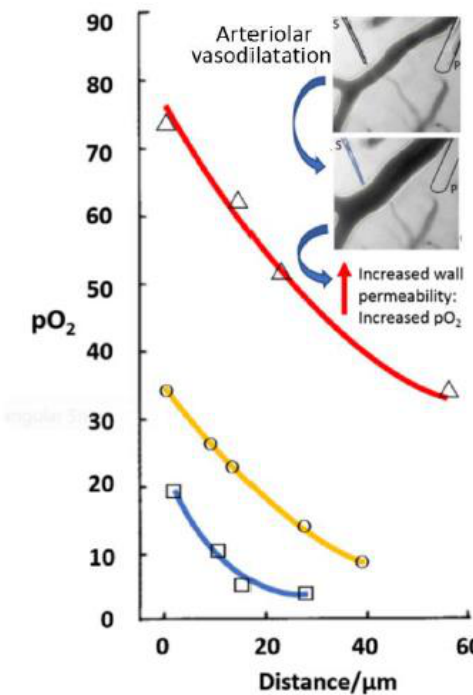
Figure 6. Rat cortical tissue pO 2 at varying radial distances from ( - ) arteriole, ( - ) capillary, and ( - ) venule using 4 µ m tip oxygen sensor showing exponential reduction with distance from vessel axis. Inset shows microsensor (S) on 30 µ m diameter arteriole with subsequent vessel dilatation after delivery from nearby micropipette (P). Adapted from [58].